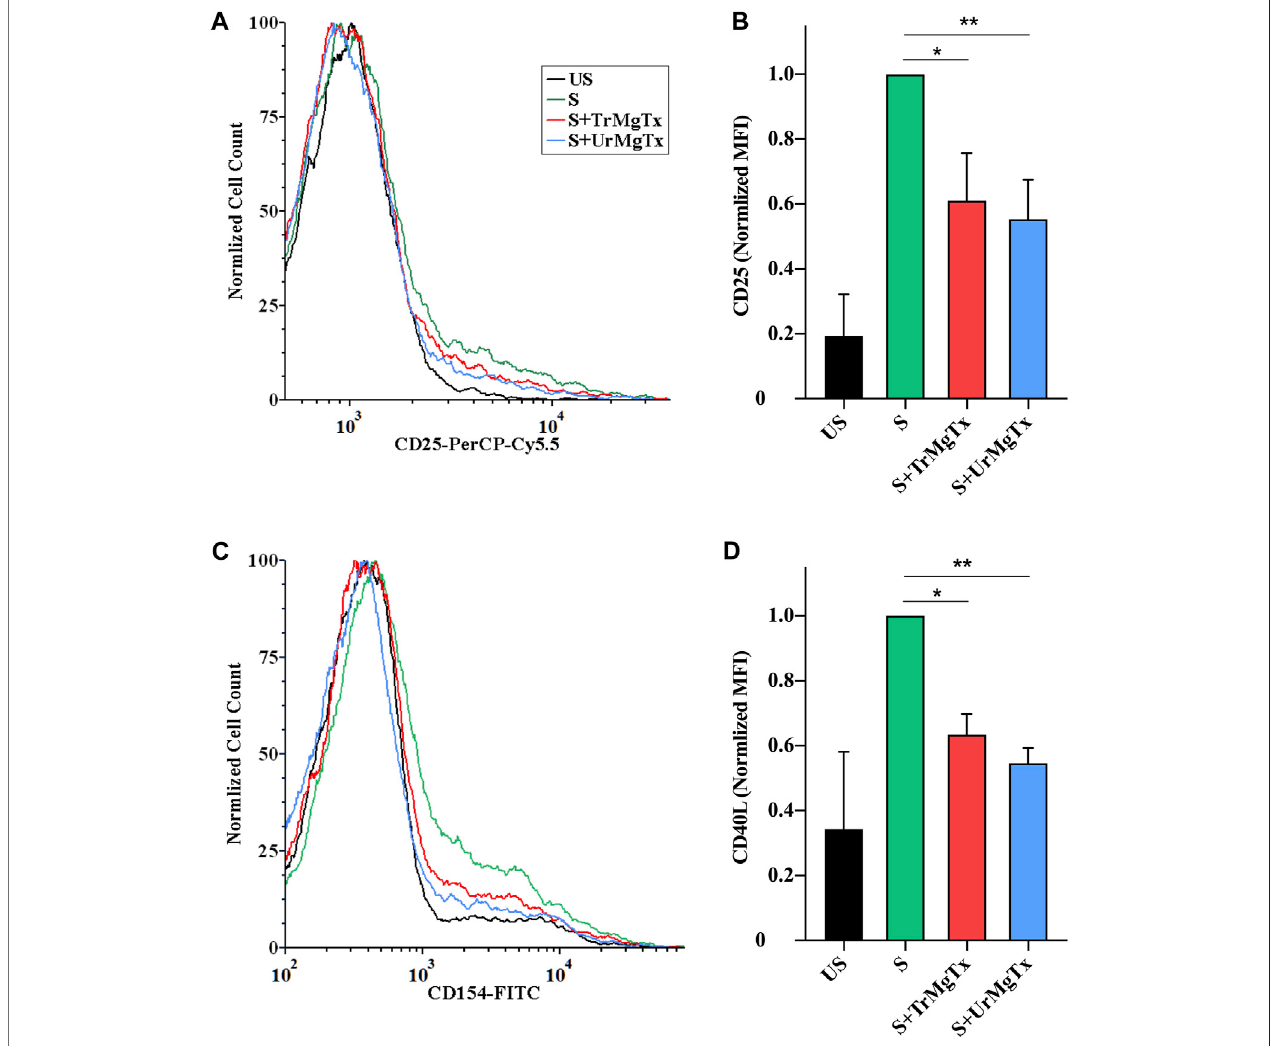
FIGURE8| rMgTxdecreasestheexpressionofIL2R(CD25)andCD40L.IsolatedCD4 + T EM cellswerestimulatedwithanti-humanCD3antibodyinthepresenceor absence of toxins. After 24 h of stimulation, cells were labelled with anti-CD25 (IL2R) (A,B) and anti-CD154 (CD40L) antibodies (C,D) . Treatment labels: US, unstimulated (black); S, stimulated with anti-human CD3 antibody – coated wells ( 5 µg/well; see the Materials and Methods section for details, green); S + TrMgTx, stimulatedinthepresenceofTrMgTx(8.5 nM,red);S+UrMgTx,stimulated inthepresenceofUrMgTx(5 nM,blue). (A,C) Fluorescencehistogramswereobtained fromTlymphocytesgatedbasedontheirFSCandSSCparameters(10,000eventswererecorded),andthen,histogramscorrespondingtoCD25orCD154expression were plotted as peak-normalized overlay. Plots were made using FCS Express 6.0. ( A,C ) has the same color code. (B,D) Mean fl uorescence intensities (MFI) were determined from the histograms and normalized to that of their stimulated but not treated control (S). Data represent values from three independent experiments (two technical repeats in each) with SEM. Signi fi cant differences of IL2R and CD40L expression between the stimulated samples in the absence and presence of toxin is indicated with asterisks (* p < 0.05, ** p < 0.01, all pairwise multiple comparison).